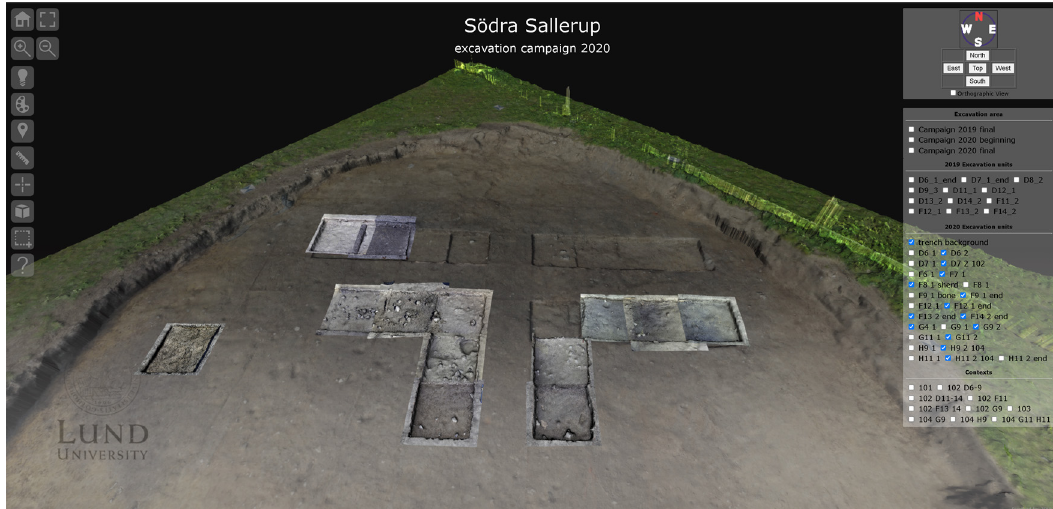
Figure 2: The 2020 interactive visualisation system of Södra